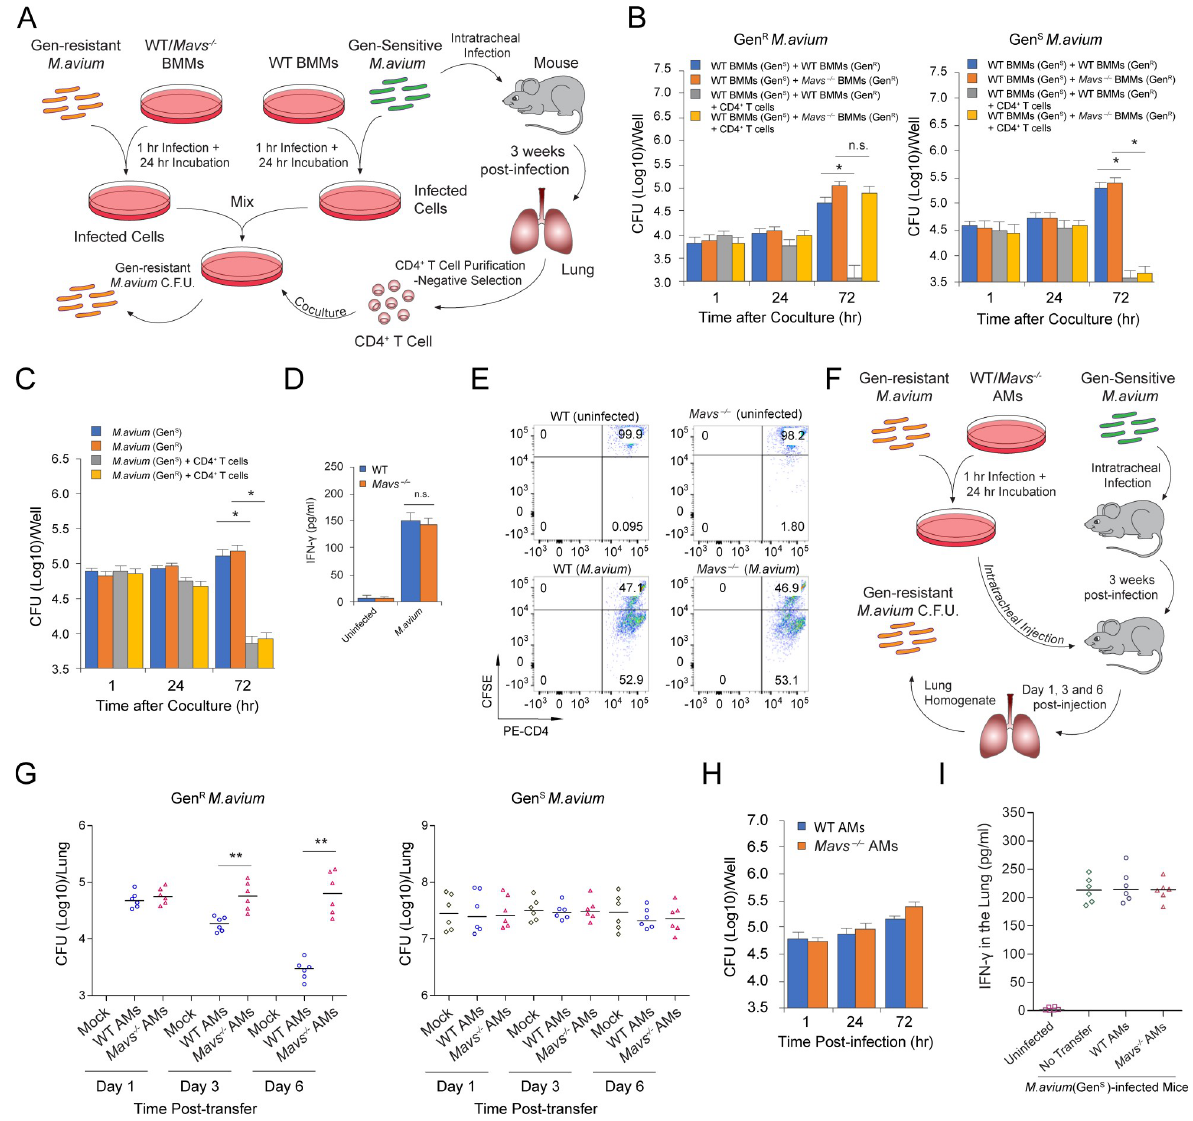
Fig 6. MAVS-dependent RNA sensing pathway contributes to CD4 + T cell-mediated mycobacterial killing in mice. (A) Schematic of coculture assay with triple cell populations. (B) Gentamycin-resistant (Gen R ) and -sensitive (Gen S ) M . avium burden in WT and Mavs -/- BMMs cocultured with CD4 + T cells from M . avium -infected WT mice using the triple-cell coculture system. (C) Bacterial counts of Gen R and Gen S M . avium strains in WT BMMs +/- coculture with CD4 + T cells purified from M . avium -infected WT mice. (D) IFN- γ concentration in the culture supernatant after 72 hr incubation of the triple-cell coculture system as described in (B). (E) Similar to (D), but flow cytometry analysis for CFSE stained CD4 + T cells following a 72 hr coculture with CD4 + T cells. (F) Schematic of the adoptive transfer assay using M . avium -infected AM and WT mice. (G) Gen R and Gen S M . avium burden in WT mouse lung at day 1, 3 and 6 after M . avium -infected AM adoptive transfer. WT and Mavs -/- AM were isolated from WT and Mavs -/- na ï ve mice, respectively. Mock, no injection. (H) Gen R M . avium burden in WT and Mavs -/- AMs in vitro. (I) IFN- γ concentration in WT mouse lungs 6 days after the M . avium -infected AM transfer. Data in (B-D) and (H) are the mean ± SD (n = 3 independent infections per group), and data shown are representative of at least three (B-E, and H) or combination of two (G and I, n = 3 per group each experiment) independent experiments. In triple-cell population coculture, a ratio: Gen S M . avium -infected BMMs: Gen R M . avium -infected BMMs:T cells = 4:1:10, was used. n.s., not statistically significant, � P < 0.05 and �� P < 0.01 by Student’s t-test (two-tailed) (B-D) or Mann–Whitney U test